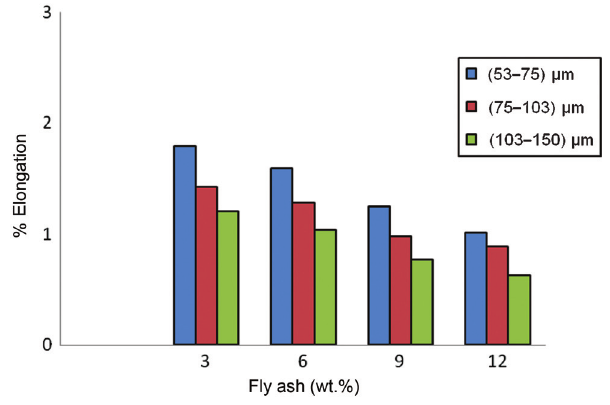
Figure 5 Influence of fly ash percentage and particle size on ductility.